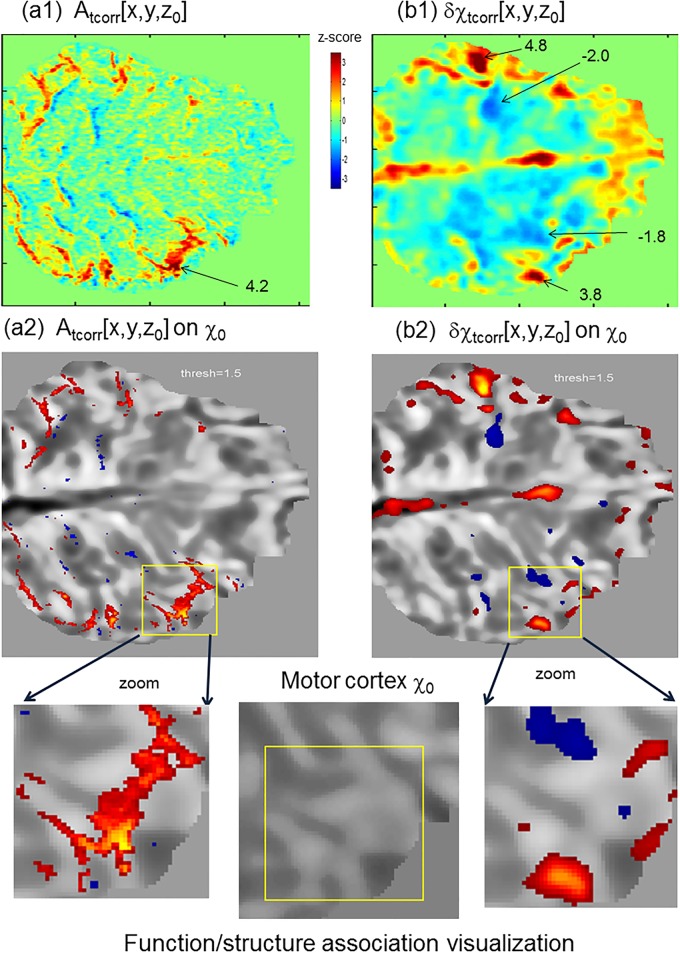
Visualization of magnitude- and susceptibility-depicted brain fmaps (on the reconstructed χ motor cortex image).(a1,a2) Magnitude-based fmap (Atcorr); (b1, b2) BOLD χ-depicted fmap (δχtcorr). The magnified insets are for scrutinizing function/structure associations. The numbers in (a1,a2) denote the z-scored tcorr values at the activation blobs.